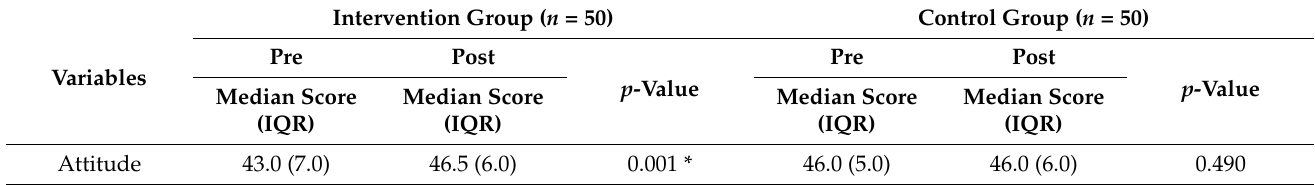
Table 4. Food poisoning preventive attitude score before and after intervention among respondents ( n = 100).